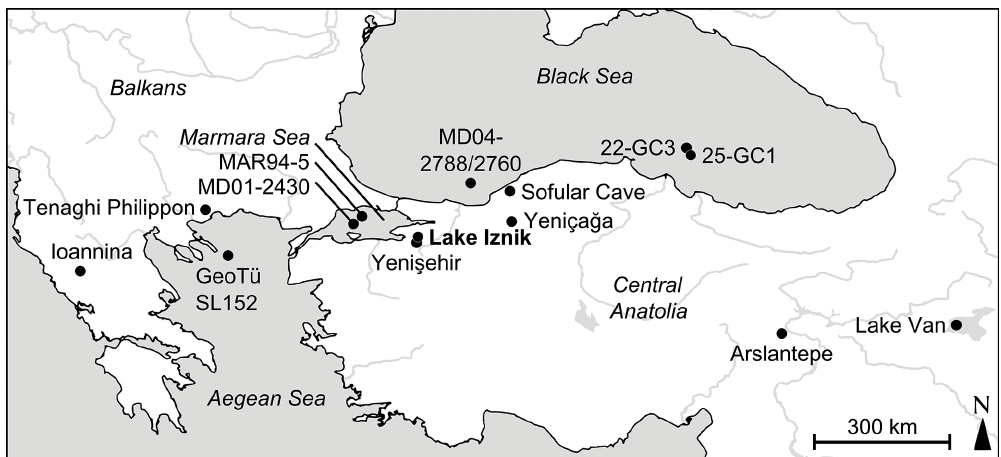
Figure 1. Regional overview modified from Roeser et al. (2012). Dots indicate Lake Iznik (this study) and paleo records mentioned in the discussion: Ioannina (Lawson et al., 2004), Tenaghi Philippon (Tzedakis et al., 2004; Müller et al., 2011), GeoTü SL152 (Kotthoff et al., 2008), MAR94-5 (Mudie et al., 2002), MD01-2430 (Valsecchi et al., 2012), Yeni¸sehir (Bottema et al., 2001), MD04-2788/2760 (Kwiecien et al., 2009), Sofular Cave (Fleitmann et al., 2009; Göktürk et al., 2011), Yeniça˘ga (van Zeist and Bottema, 1991), 22-GC3 (Shumilovskikh et al., 2012), 25-GC1 (Shumilovskikh et al., 2014), Arslantepe (Masi et al., 2013), and Lake Van (Wick et al., 2003; Litt et al., 2009).